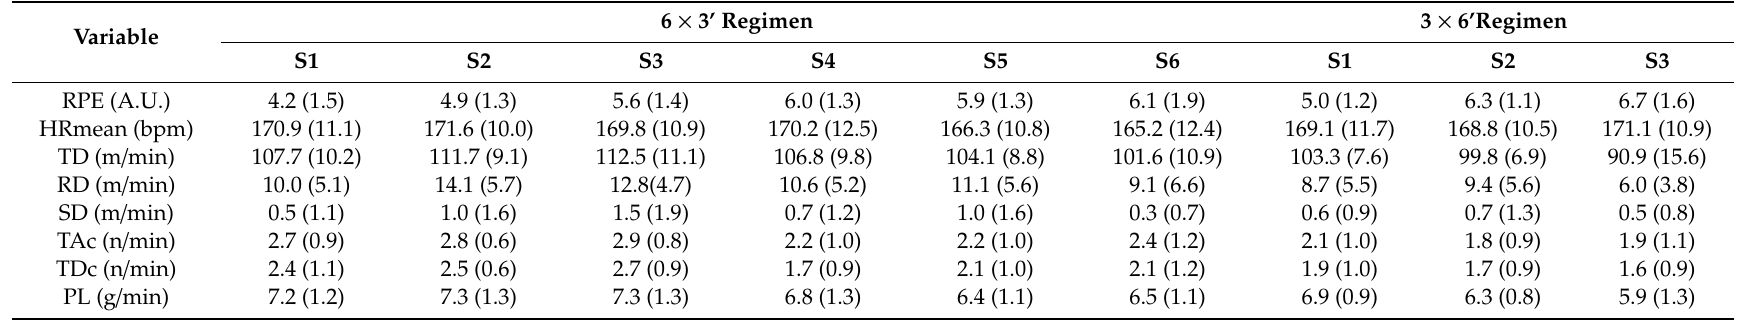
Table 1. Descriptive statistics (Mean (Standard Deviation)) of internal and external load during the SSGs.